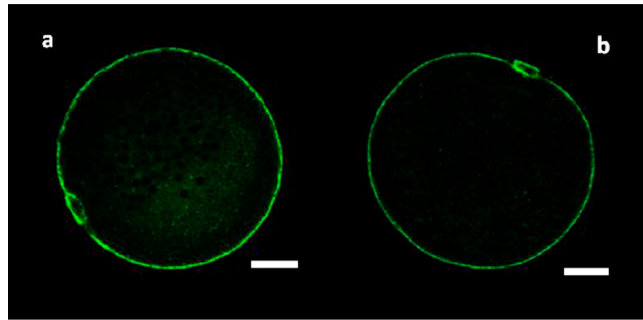
Figure 1. Cortical granule localization before in vitro maturation (IVM). Representative images of porcine oocytes after isolation of oocytes from small ( a ) and medium ( b ) follicles. Oocytes were stained by PNA-labeled FITC (green color—cortical granules). Scale bar represents 20 µ m.